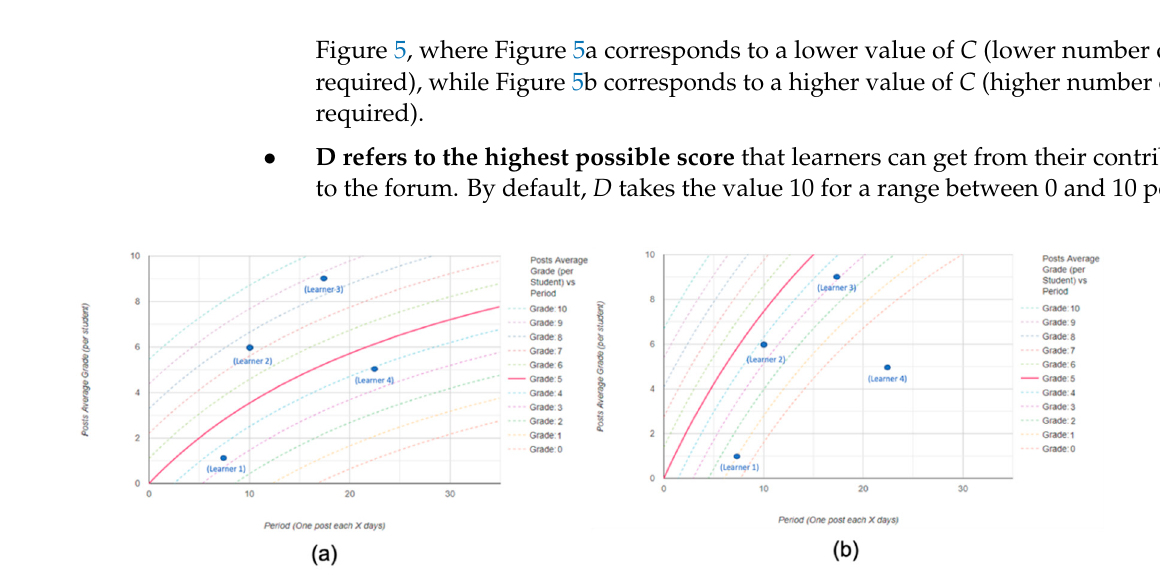
Figure 3. Chart representing f ( x ) plus some other curves calculated through the Euclidean distance to f ( x ) in the range from 0 to 10 points for two values of A: ( a ) low value of A ( b ) high value of A. Scenario ( b ) requires a higher relevance in learners’ contributions to get the same score.